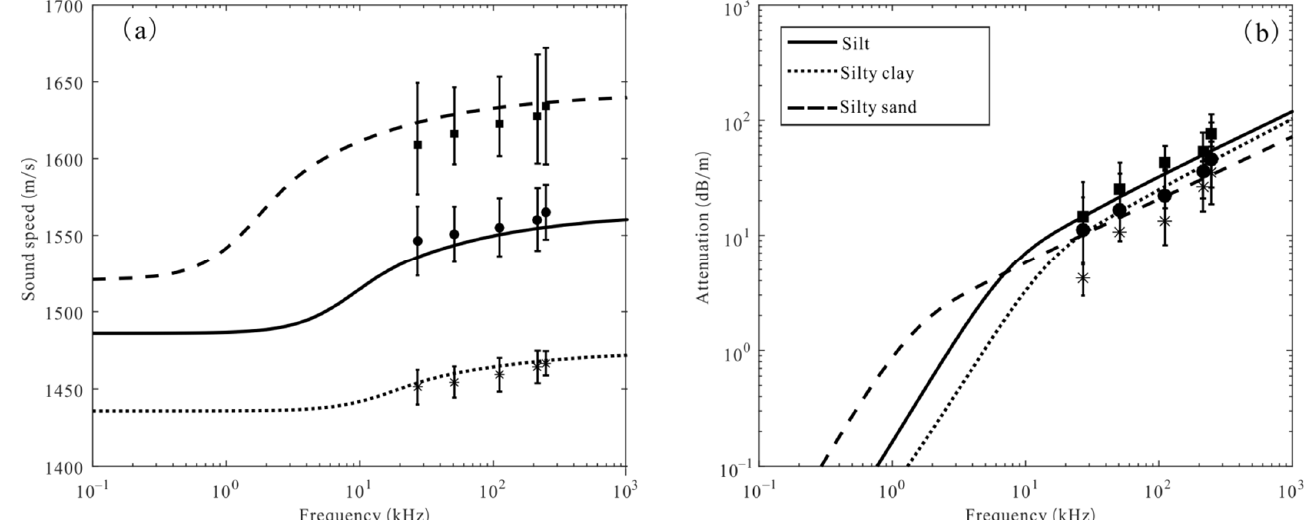
Figure 5. The sound speed ( a ) and attenuation ( b ) dispersion of different sediments in SCS. Table 2. The values of Biot–Stoll model input parameters for different sediment types.